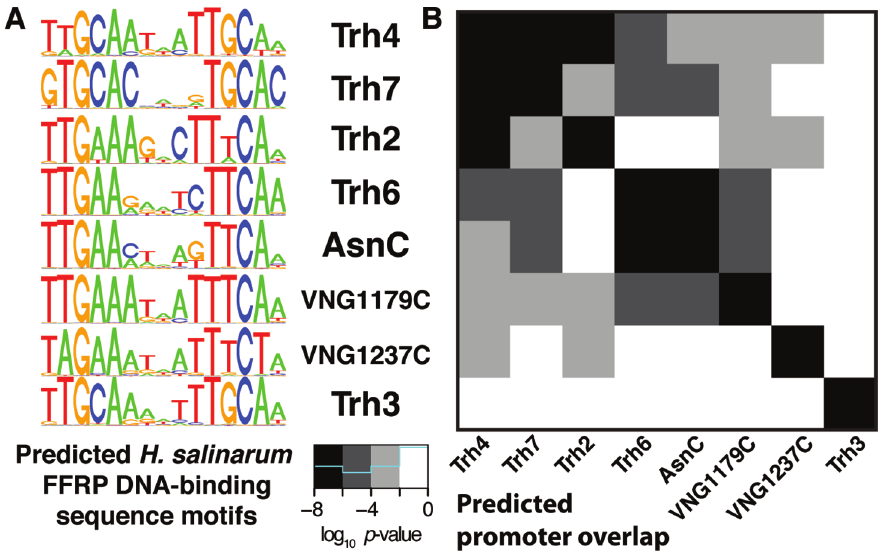
Figure 2. A) Predicted novel transcription factor-DNA binding site (TFBS) motifs for the FFRP repertoire in Halobacterium salinarum NRC-1. B) The statistical overlap between gene promoters that contain sequences matching one or more of the predicted FFRP DNA binding sites in (A). Dark boxes indicate higher overlap (hypergeometric p -value).